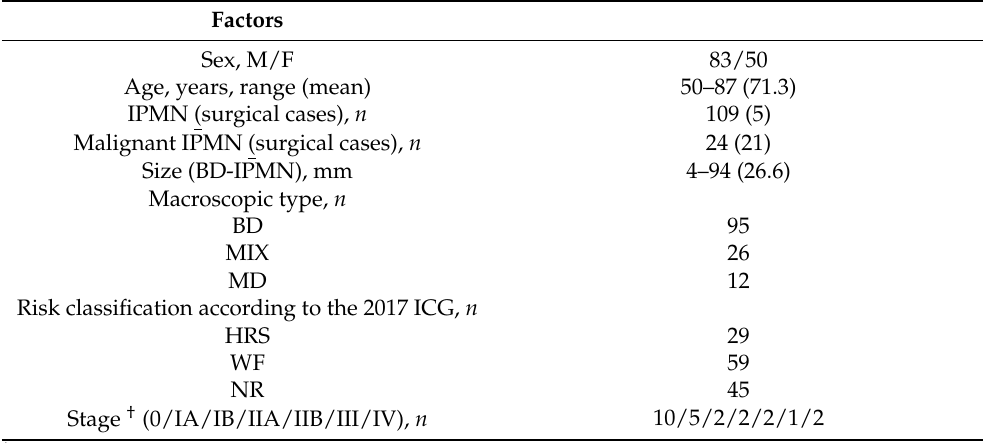
Table 1. Characteristics of patients with pancreatic